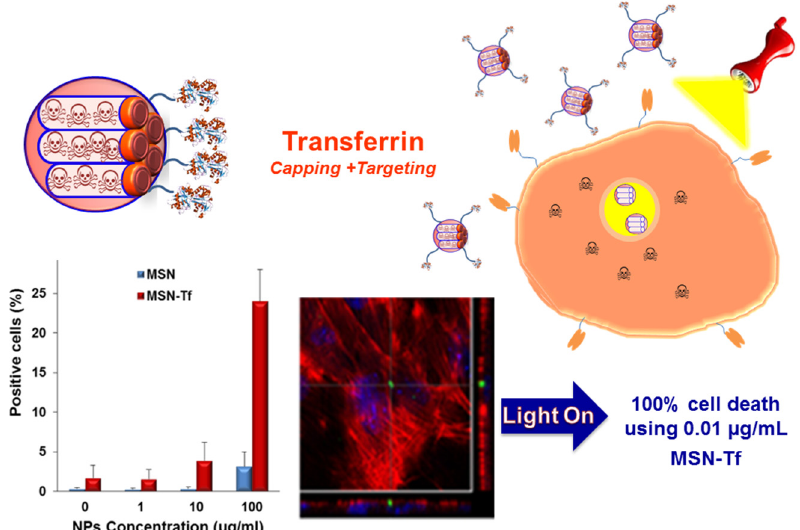
Figure 6. Up : Schematic illustration of the action mechanism of light-responsive nanosystem based in MSNs decorated with a biocompatible protein shell (transferrin, Tf, grafted to MSNs using a light cleavable photolinker), affording MSN-Tf. Down : Cellular uptake of MSNs and MSN-Tf labeled with fluorescein. Confocal microscopy images show NPs (green) inside tumor cells (actin in red, nucleus in blue). The light irradiation of MSN-Tf provokes the cleaving of the photolinker, which triggers pore uncapping and subsequent drug release